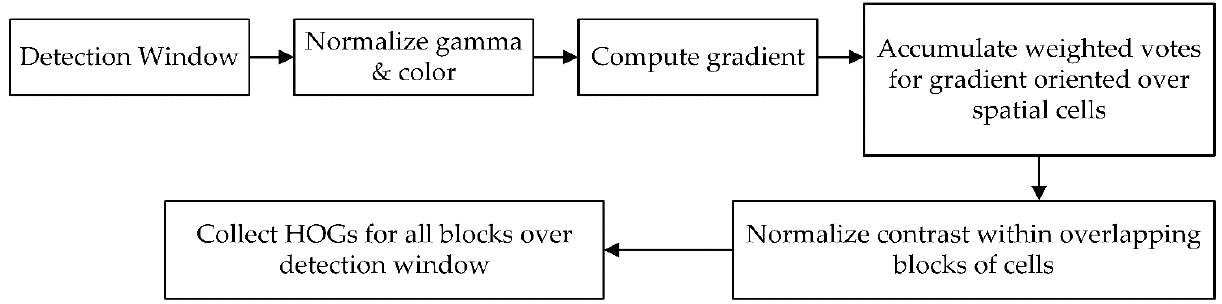
Figure 7. HOG feature extraction